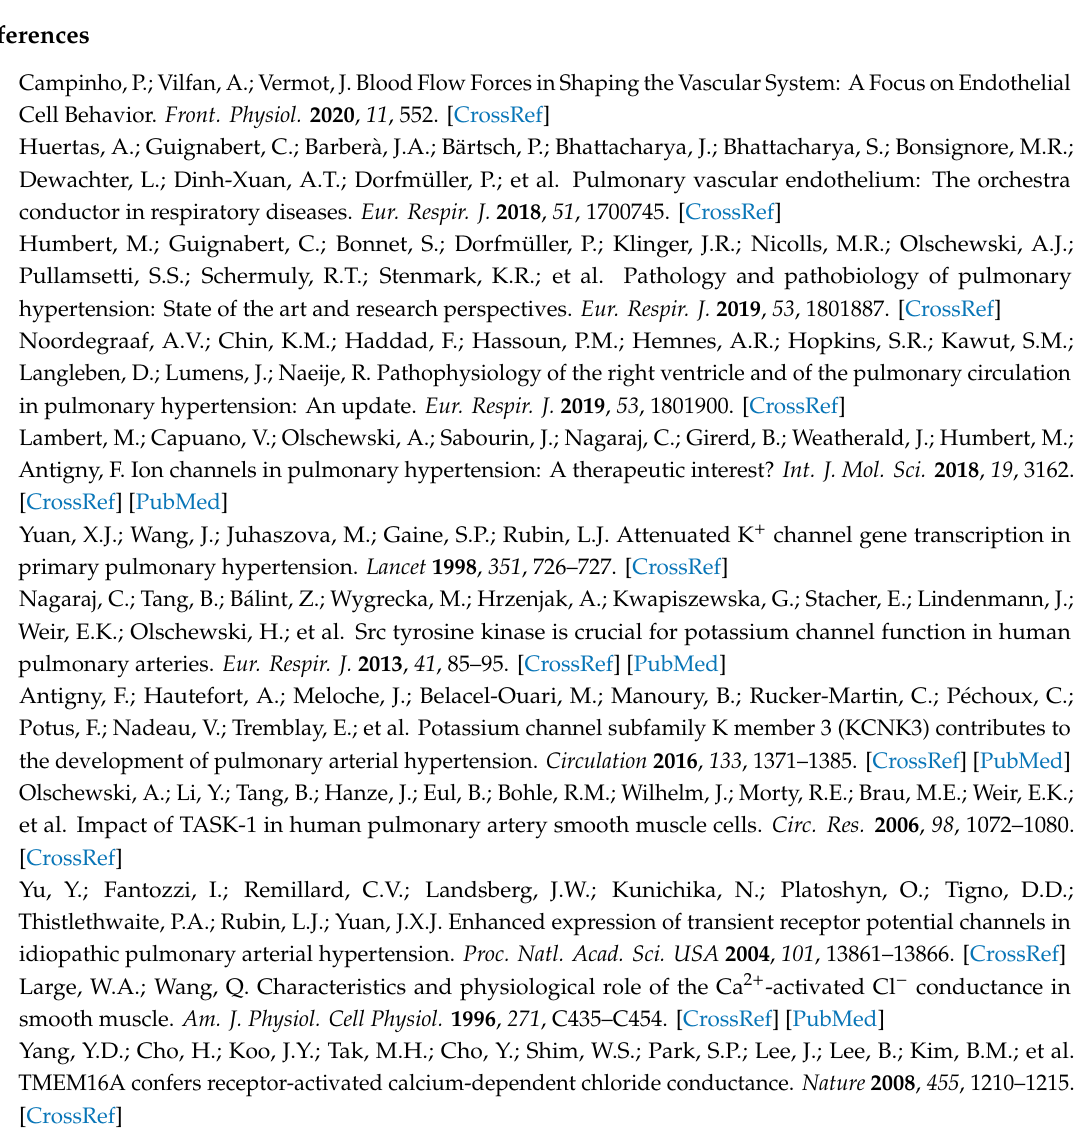
Lonza, Table S3: Primer sequences, Table S4: Antibodies used in western blot (WB) and immunofluorescence staining (IF), Table S5: Solutions, Table S6: